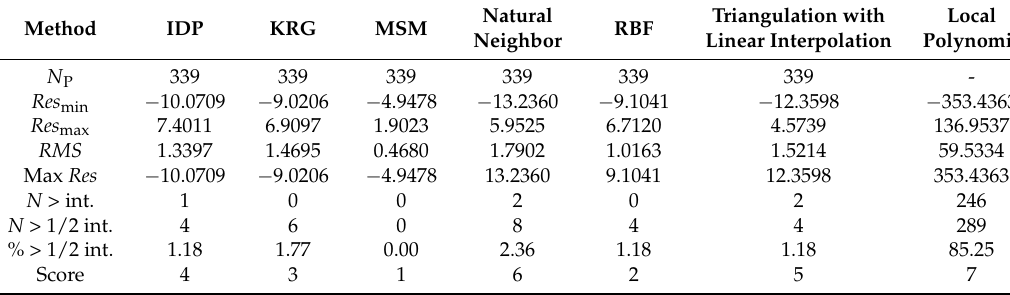
Table 2. Statistical analysis of interpolation methods residuals for gridding footwall